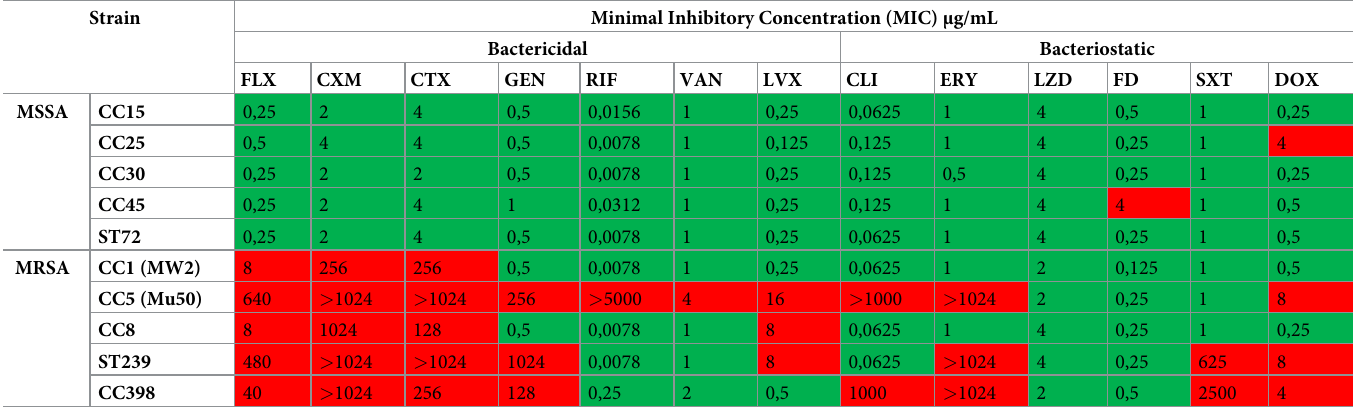
Table 4. The results of broth microdilution susceptibility testing of all strains.